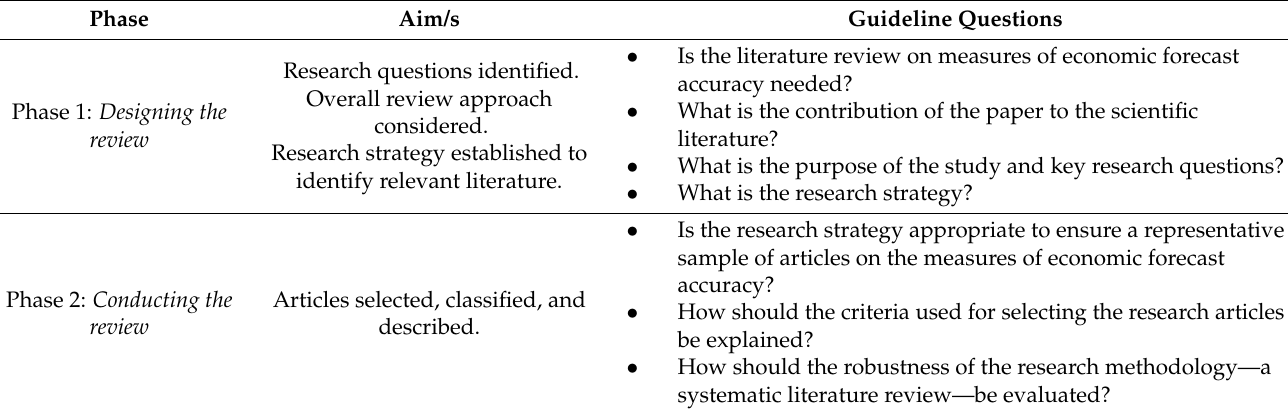
Table 1. Systematic literature review—phases and guideline